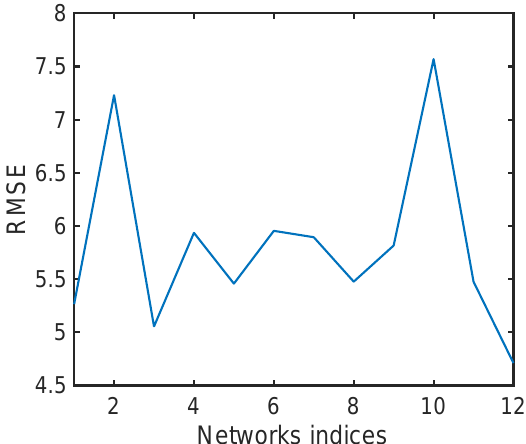
Figure 9. Root mean square errors averaged for all sources. The network corresponding to index 12 is the optimal one and has the smallest